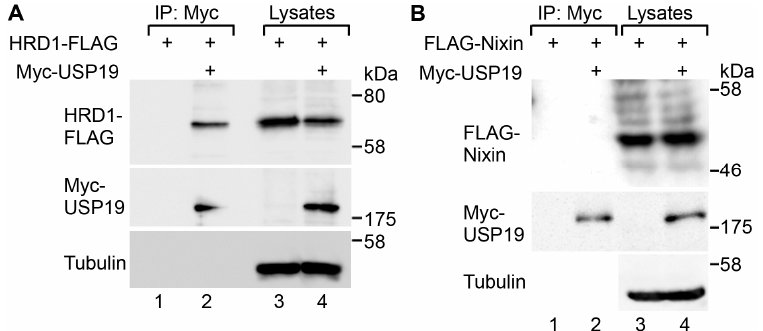
Figure 1. USP19 interacts with HRD1. The 293T cells were transfected with HRD1-FLAG ( A ) or FLAG-Nixin ( B ) along with either a pcDNA3 vector (lanes 1 and 3) or Myc-USP19 (lanes 2 and 4). The cells were lysed and then subjected to immunoprecipitation (IP) with an anti-Myc antibody. The lysates (10% of the input; lanes 1 and 2) and the immunoprecipitates (50% of the eluates; lanes 3 and 4) were analyzed by Western blotting with antibodies against FLAG ( top panels), Myc ( middle panels) and α -tubulin (an internal loading control; bottom panels).